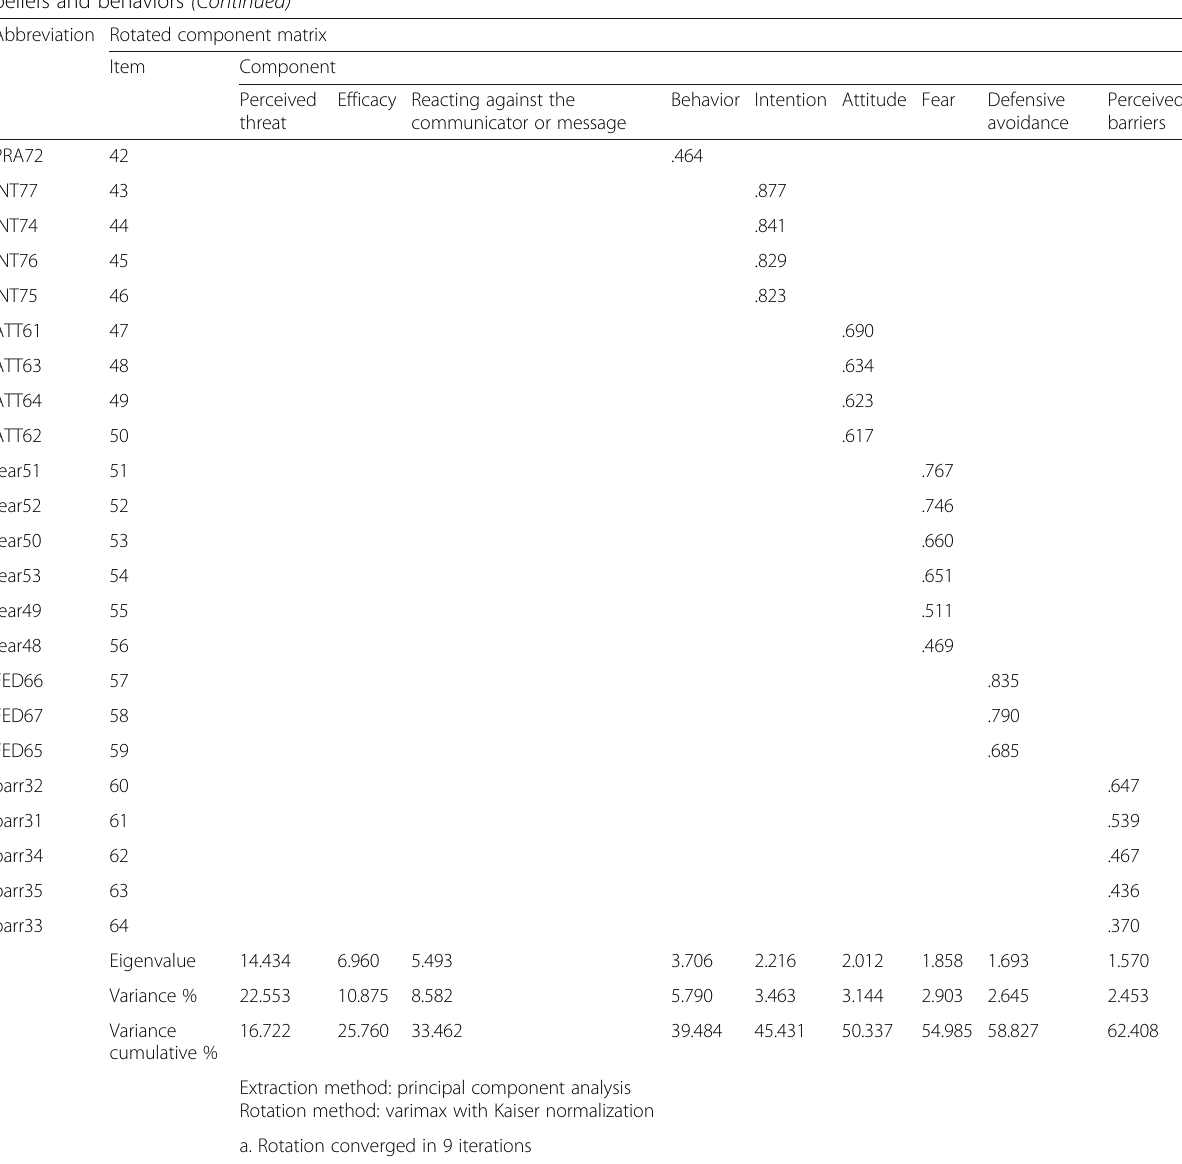
Table 1 Factor analysis and reliability results for discovery of main factors of questionnaire for evaluation of waste segregation beliefs and behaviors (Continued) Abbreviation Rotated component